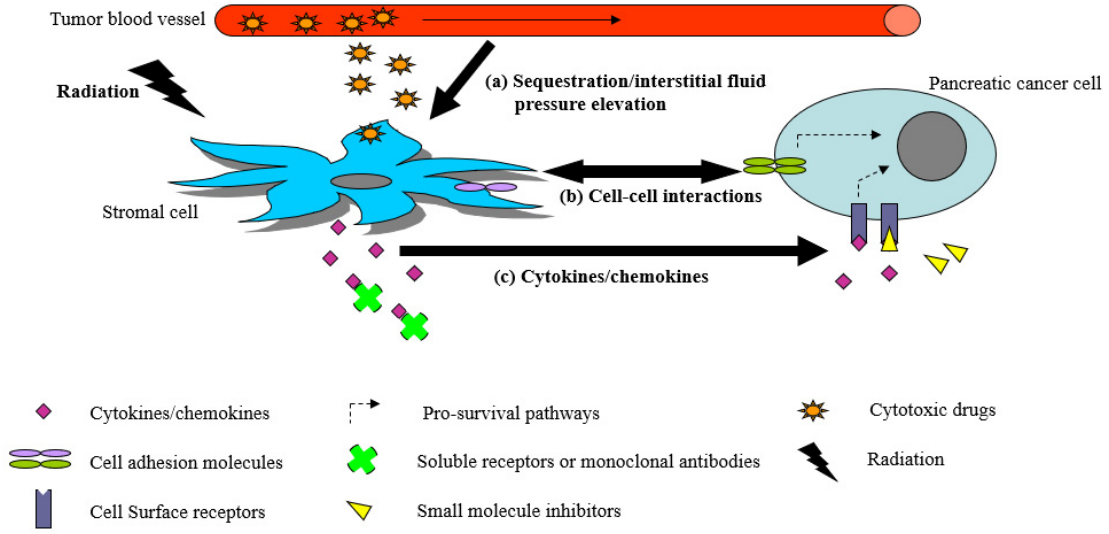
Figure 1. Potential mechanisms by which stromal cells such as pancreatic cancer-associated fibroblasts (CAFs) and immune cells contribute to radiotherapy/chemotherapy resistance in pancreatic cancer. ( a ) Given their large population in the pancreatic tumor stroma, CAFs may sequester cytotoxic drugs. CAFs often exhibit increased contractility and exert increased tension on the modified extracellular matrix (ECM) in the pancreatic tumor mass, resulting in elevated intratumoral interstitial pressure and decreased cytotoxic drug delivery to pancreatic cancer cells. ( b ) Physical interactions between stromal cells and pancreatic cancer cells may increase the activity of pro-survival pathways in the latter. ( c ) Stromal cells are avid producers of many growth factors, cytokines/chemokines, and ECM proteins. Binding to some of these molecules to their respective receptors on pancreatic cancer cells may also increase pro-survival signaling, leading to increased protection from the cytotoxic effects of radiotherapy/chemotherapy. Therefore, blocking the action of specific soluble factors and cytokines released by stromal cells with monoclonal antibodies or small molecule strategies to enhance radiosensitivity/chemosensitivity of pancreatic cancer